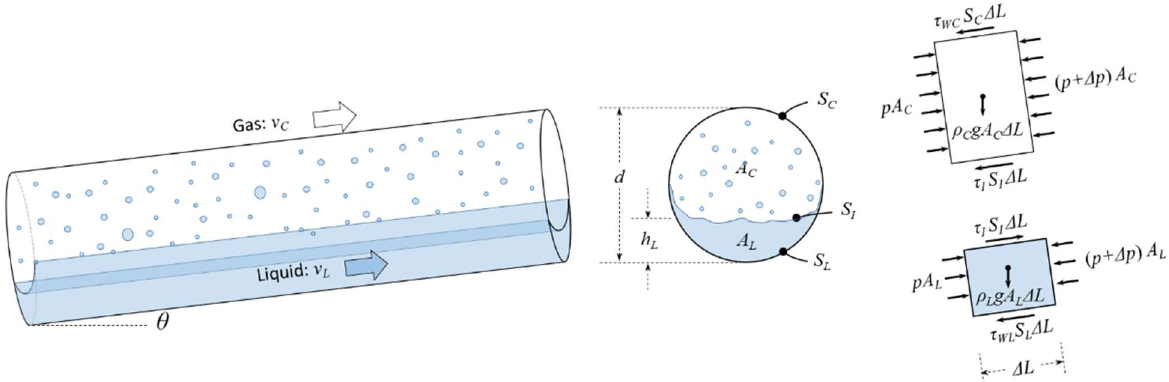
Figure 1. Parameters and forces in two-fluid model for segregated flow.